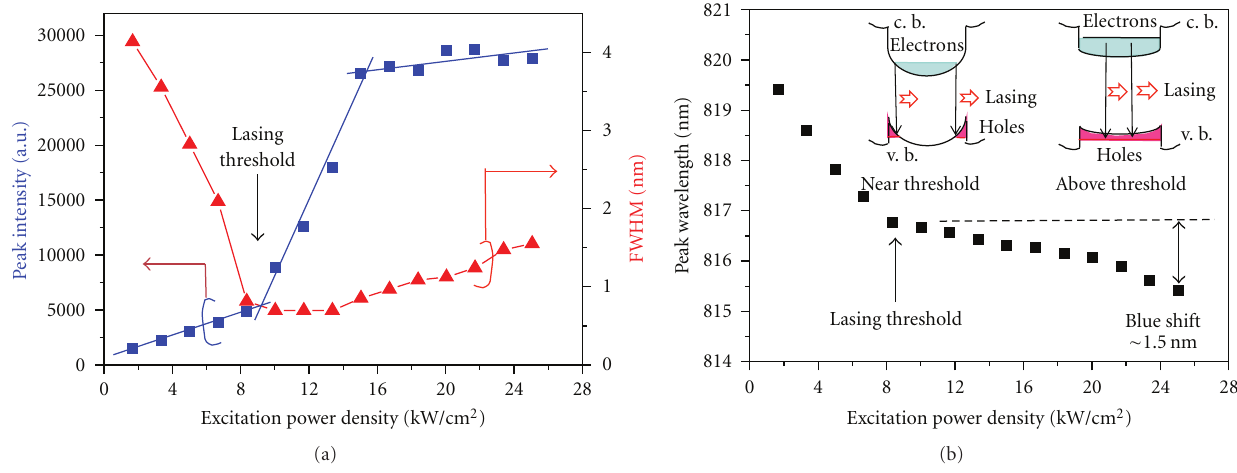
Figure 26: PL peak intensity/wavelength as function of excitation power density. (a) Plots of emission peak intensity (marks with filled squares) at center wavelength of 816nm and full width at half maximum (FWHM) (marks with filled triangles) of PL spectra. (b) Plots of lasing peak wavelength versus excitation power density. Inset indicates how band bending of conduction band (c. b.) bottom and valence band (v. b.) top change as densities of accumulated photoexcited electrons and holes increase